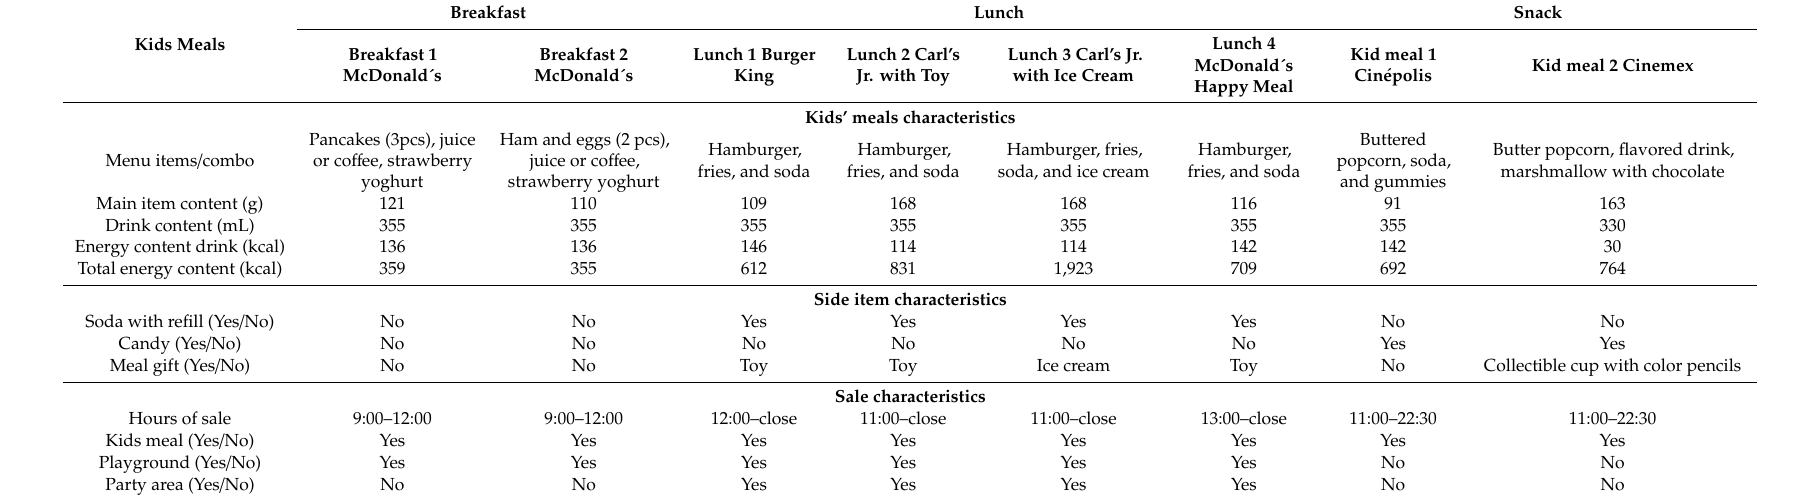
Table 1. Characteristics of kids’ meals sold at fast food restaurants and movie theaters in the city of San Luis Potos í